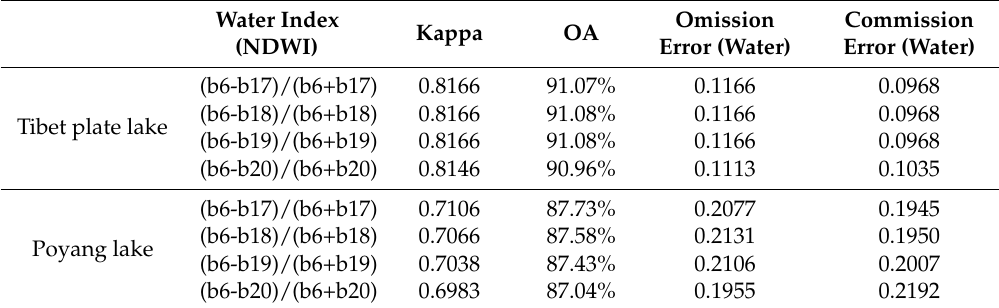
Table 2. Accuracy assessment of the water body maps produced by OTSU segmentation with different NDWI images for Tibet Plate lake and Poyang